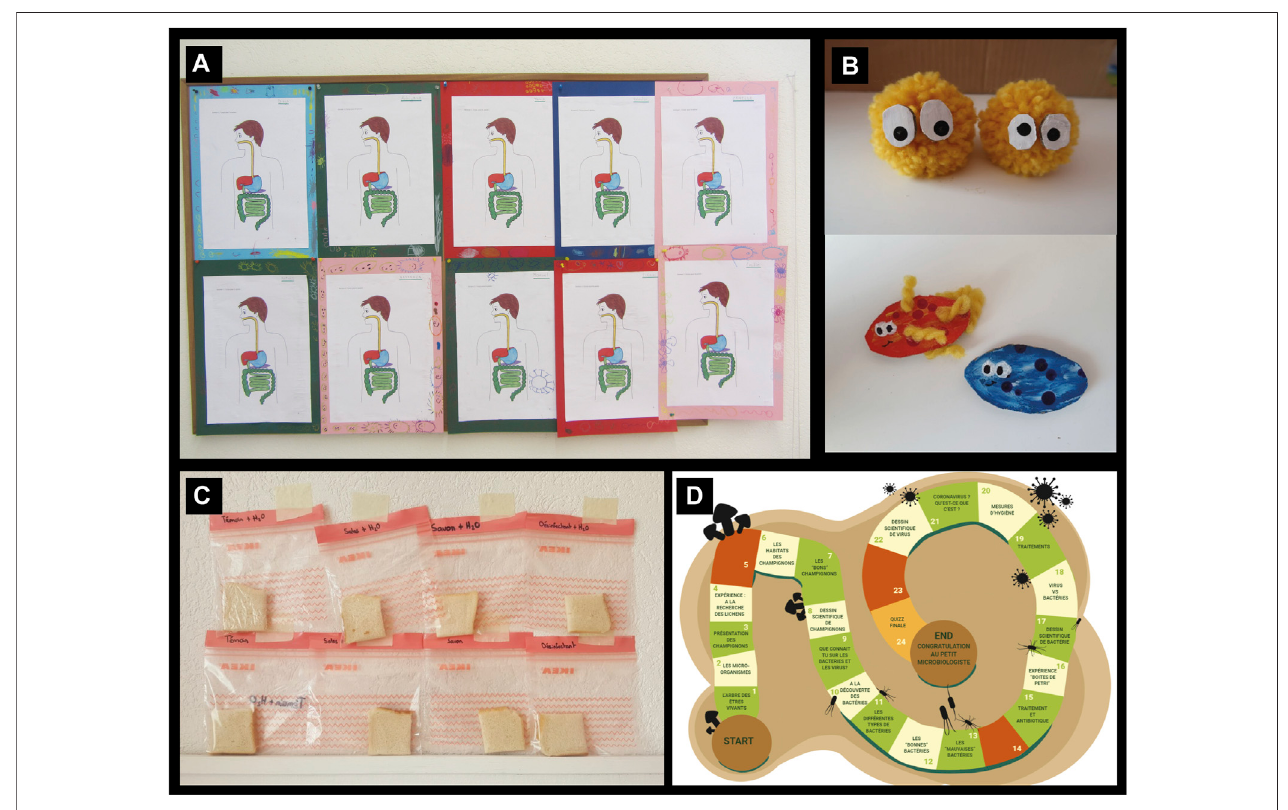
FIGURE 1 | Examples of the material created by the students in 2020 to develop their activities. Sketches of the human bodies coloured by the pupils (A) . In those sketchesthechildrenhadtoplacethemicrobestheyhadcrafted (B) toillustratewheretheyexpectedto fi